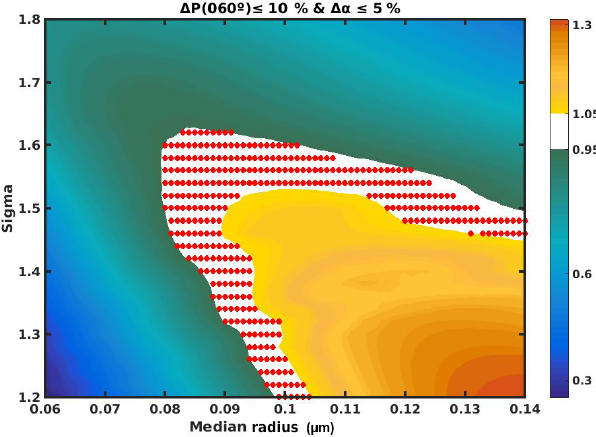
Figure 20. Contour plot showing the ratio of the Ångström coeffi- cient α for a given aerosol size distribution to the V1 aerosol size distribution α ≈ 2. Cases for which this ratio is within ± 5% of 1 are highlighted in white. The coarse-mode properties are fixed in this example at the V1 aerosol size distribution values ( r 2 = 0 . 32µm; σ 2 = 1 . 6), while the fine-mode properties vary in the vicinity of the V1 aerosol size distribution values ( r 1 = 0 . 09µm; σ 1 = 1 . 4). Red circles indicate the individual cases calculated to create this figure.